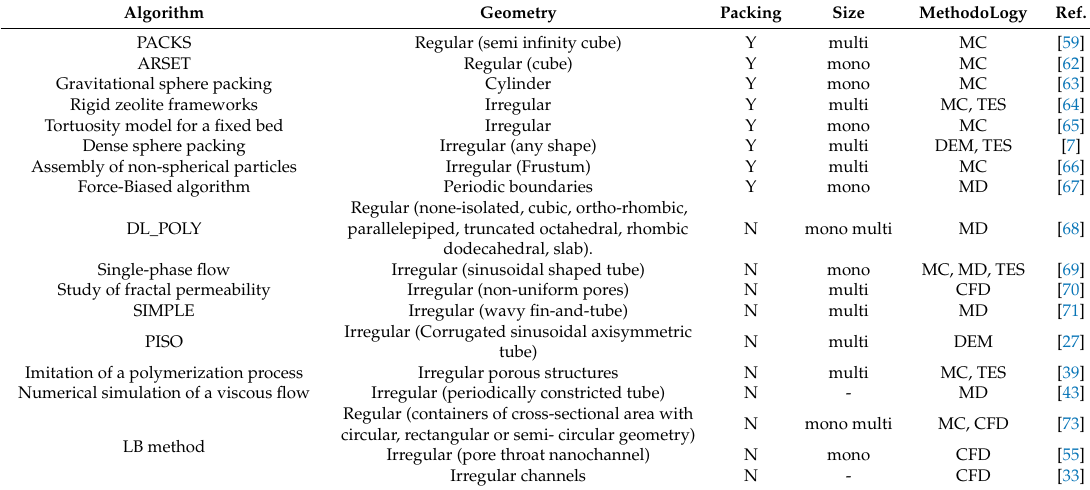
Table 3. Properties of Reviewed Algorithms.